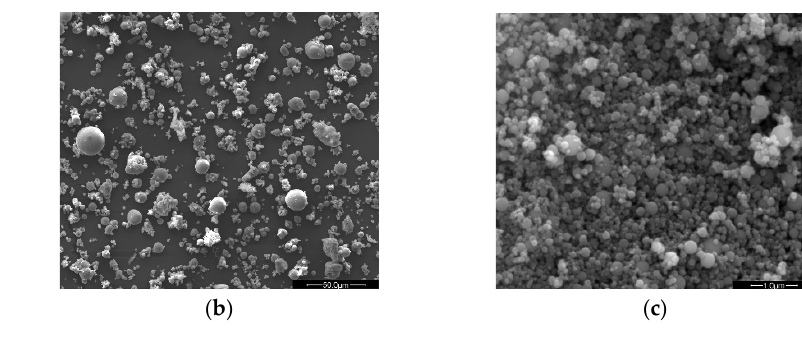
Figure 2. Particle morphology of raw materials. ( a ) Cement; ( b ) FA; ( c ) SF. Table 1. Chemical composition of raw materials/%.